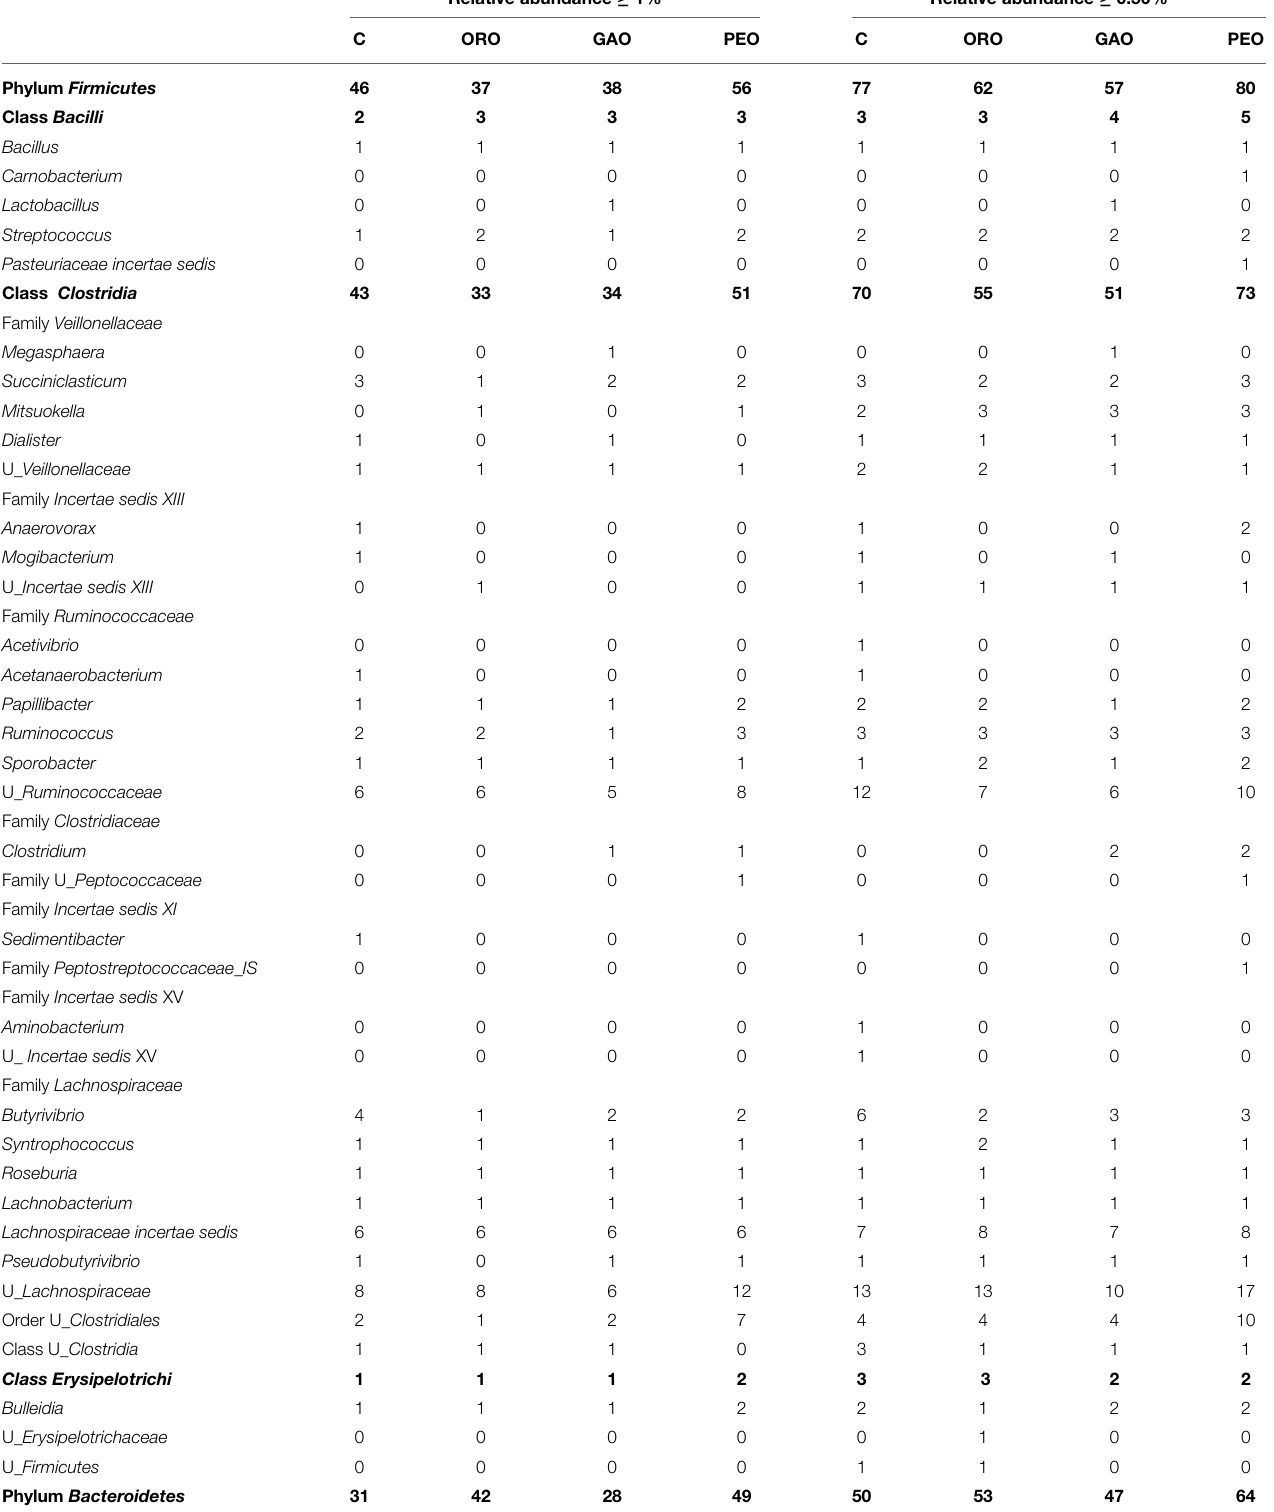
TABLE 1 | Effects of essential oils on richness and distribution of major ruminal bacterial